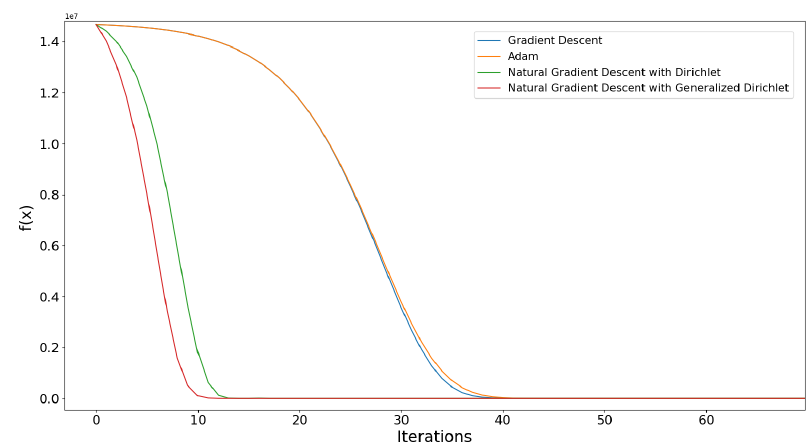
Figure 1. The rate of convergence on Rayden function using various